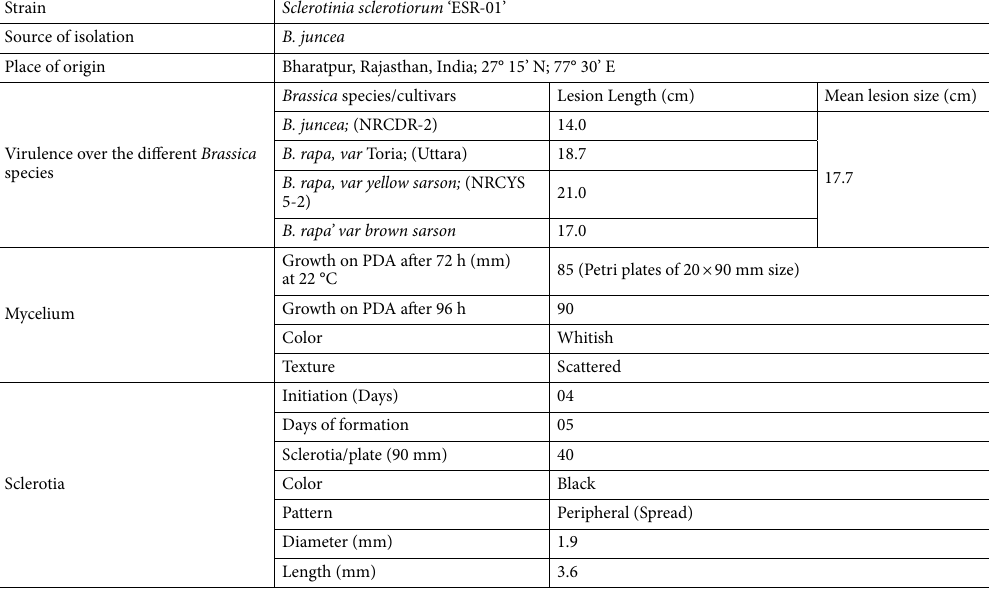
Table 3. The geographical origin, pathogenicity, growth, and morphological characteristics of the S. sclerotiorum ‘ESR-01’